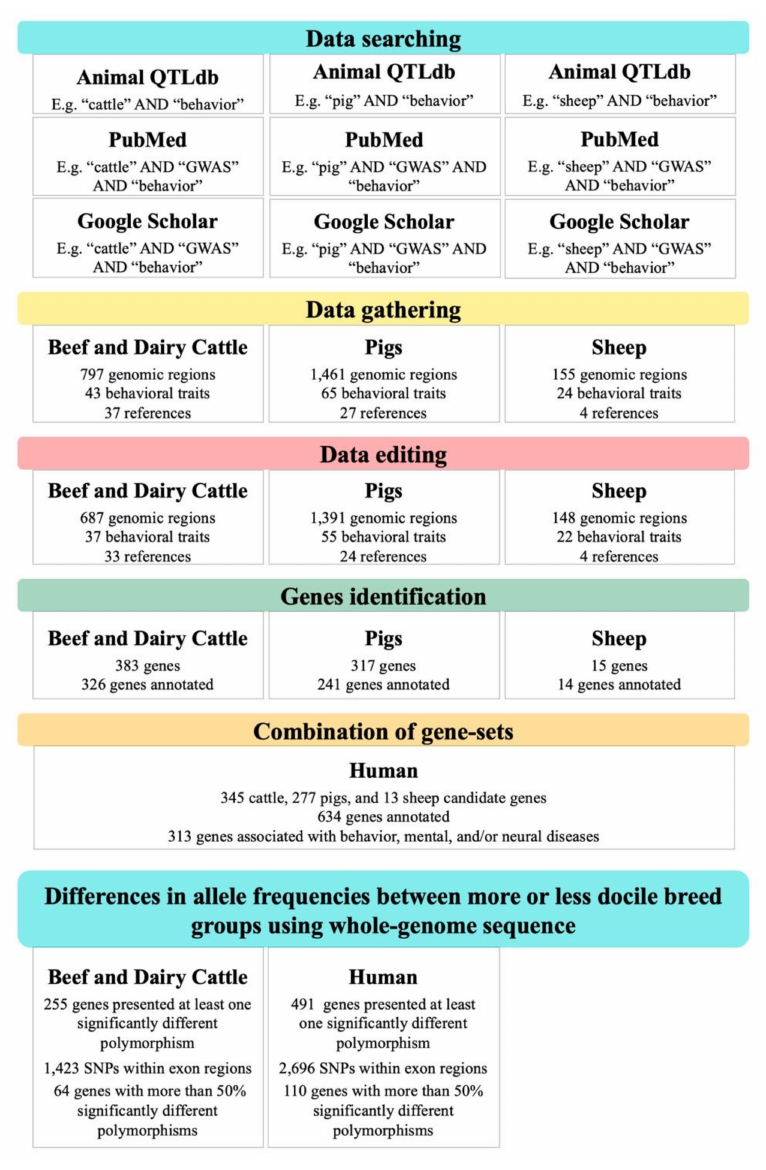
Figure 1. Workflow of the systematic review of genomic regions associated with behavior-related traits in farmed mammals and human homologous